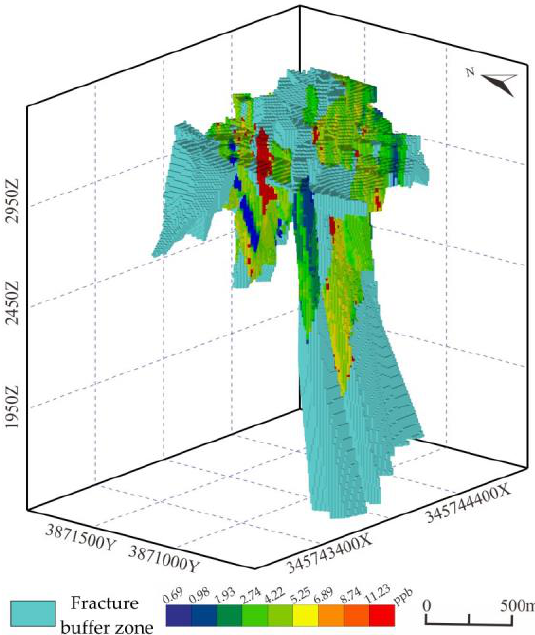
Figure 5. Three-dimensional data volume model of Au.